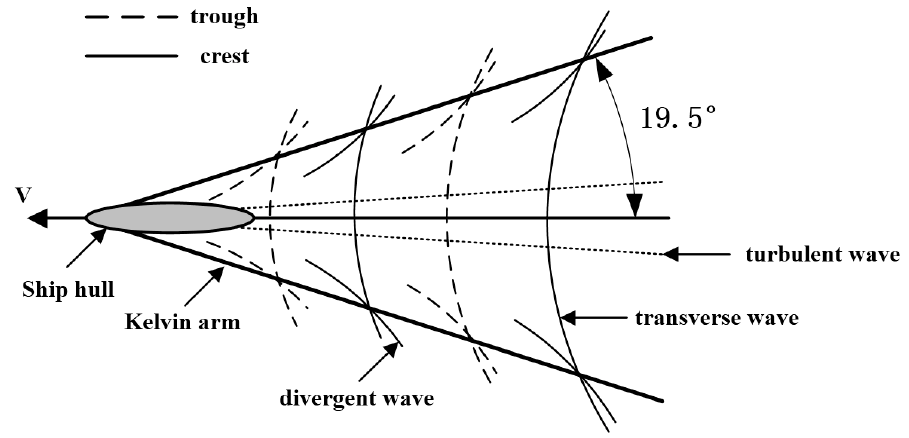
Figure 1. Kelvin wake diagram. Assuming that the ship sails along the negative x -axis at velocity U, the corresponding Kelvin wake wave height can be described as a linear superposition of many free surface waves with different propagation directions, amplitudes, and frequencies [14].